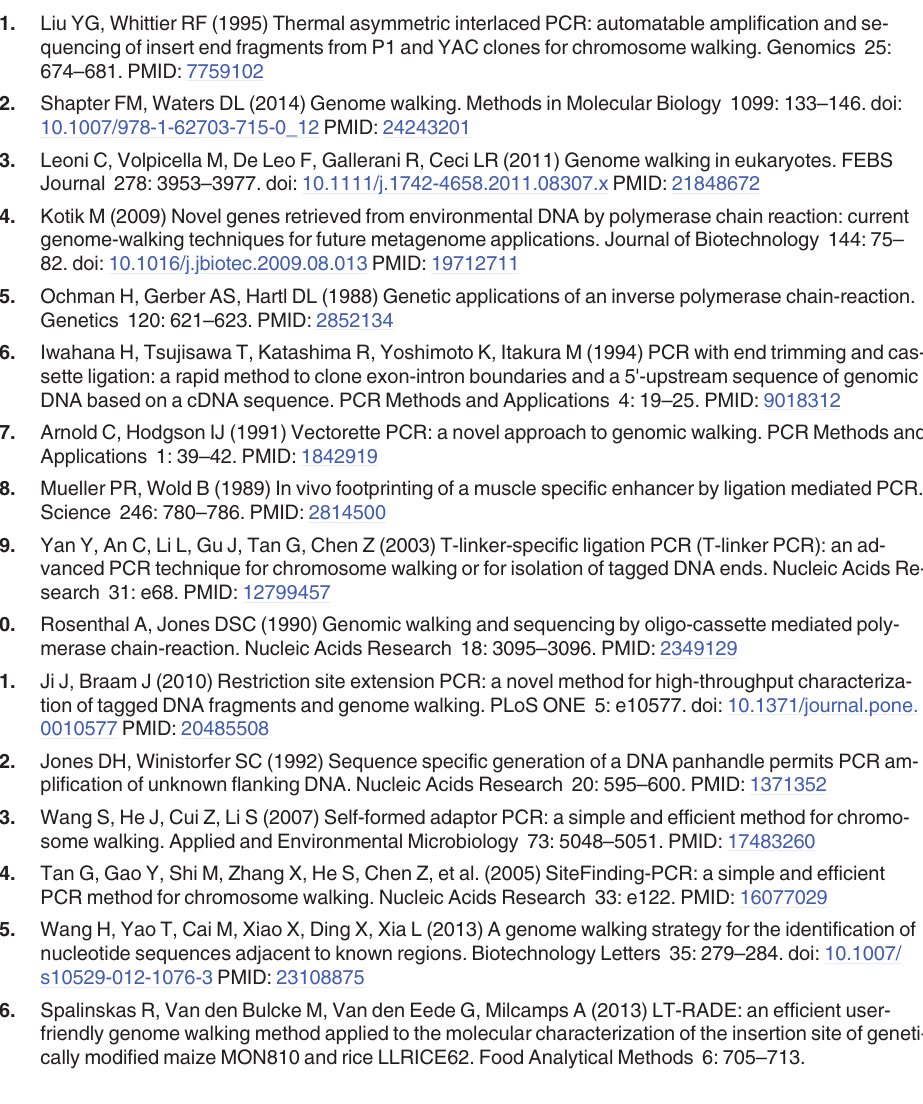
S1 Table. Thermal cycling parameters used in the partially overlapping primer-based PCR